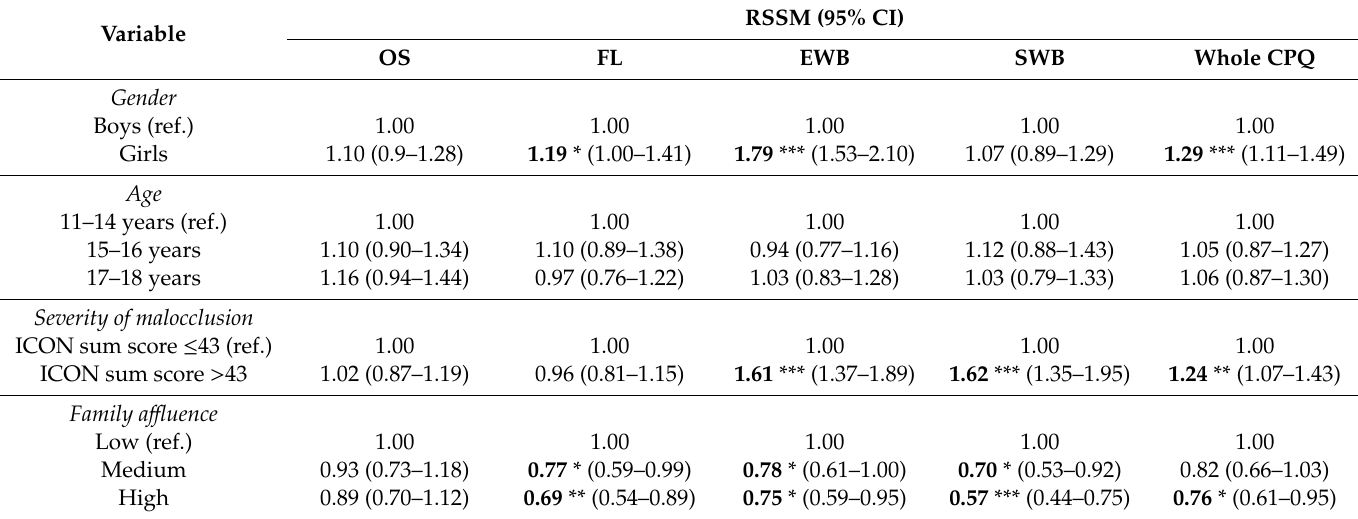
Table 3. Association of CPQ and its four domains’ sum scores with gender, age, severity of malocclusion, and family a ffl uence: results as determined by the multivariate Negative Binomial Regression (NBR)